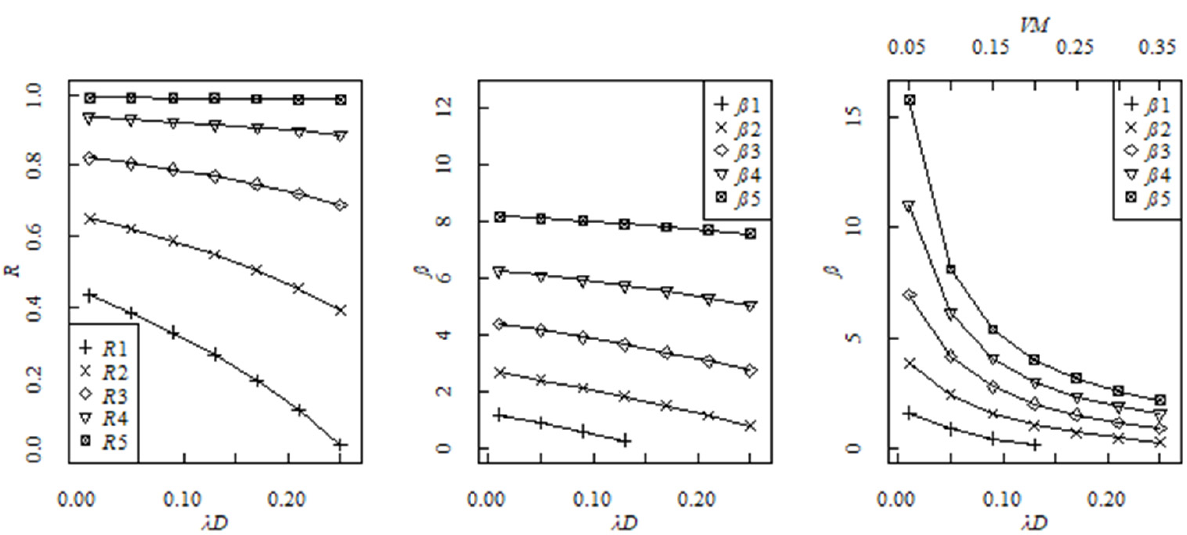
Figure 6. Different variation trends of structural robustness evaluation index ( R ) and structural reliability index ( β ) of the cantilever beam subjected to damage effect ( D λ ) and variation factor ( VM ) (Left: R vs. D λ , middle: β vs. D λ ,and right: β vs. D λ ).